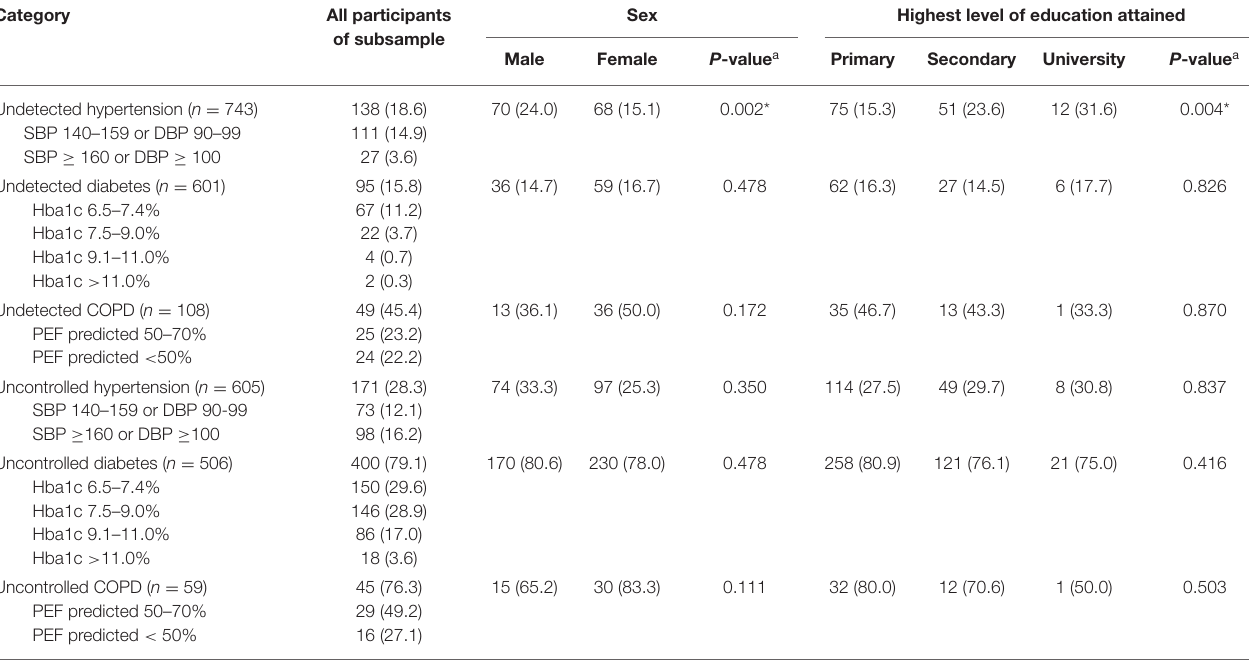
Highest level of education